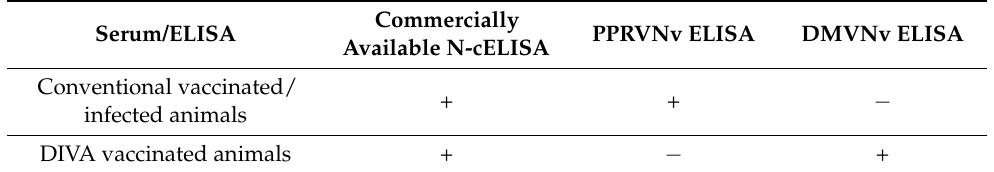
Table 1. Reactivity of the serum collected from vaccinated/infected animals in different ELISAs. +: positive; − : negative. Commercially Serum/ELISA PPRVNv ELISA DMVNv ELISA Available N-cELISA Conventional vaccinated/ + + − infected animals DIVA vaccinated animals + −